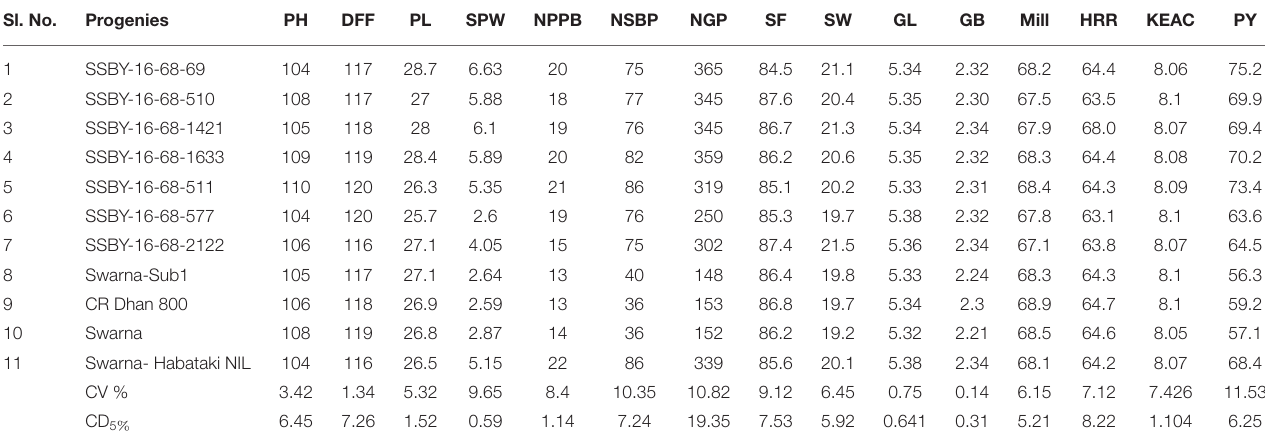
TABLE 3 | Evaluation of pyramided lines for various yield, quality, and related traits in BC 2 F 3 , BC 2 F 4 , and BC 2 F 5 generations. Sl.